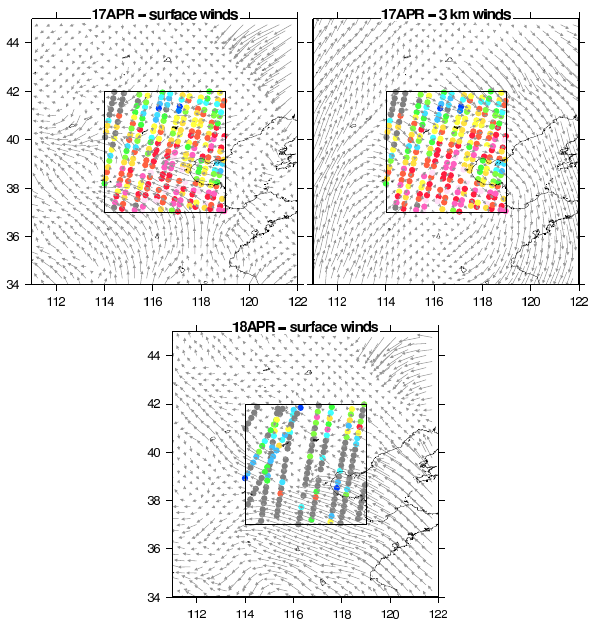
Fig. 16. Wind fields from ECMWF meteorological forecasts at the surface or at 3km over North China for 17 and 18 April. The 0–6km ozone columns measured for each individual pixel of the morning overpass over Beijing are also plotted (grey circles repre- sent cloudy pixels).